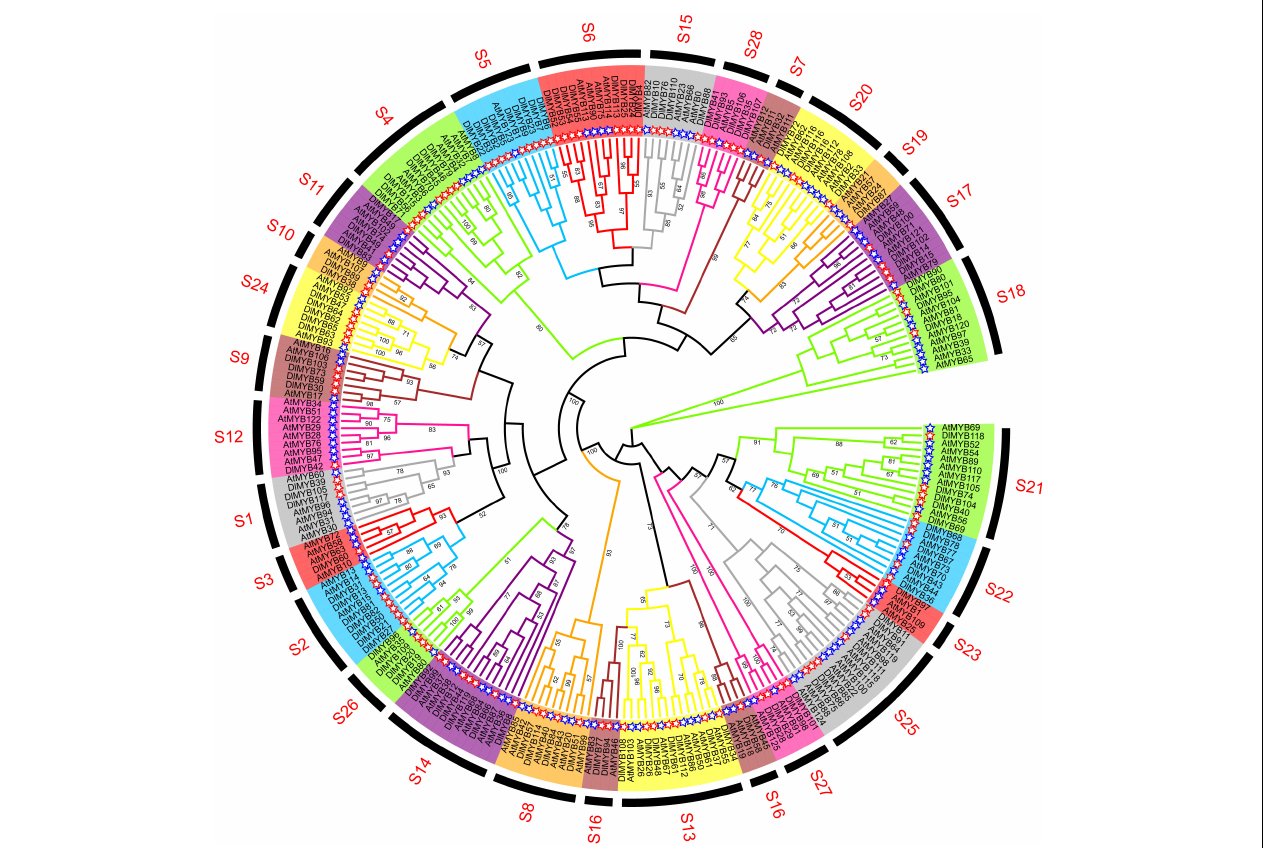
FIGURE 2 | Phylogenetic analysis of longan and Arabidopsis MYB proteins. The full-length amino acid sequences of longan (119) and Arabidopsis (126) MYB proteins were compared using RAxML software to generate ML phylogenetic trees with 1,000 bootstrap values. The Evolview3 was used to visualize and display > 50 bootstrap values at the nodes. Red and blue stars represent DlMYB and AtMYB proteins, respectively. All MYB proteins were divided into 28 subgroups